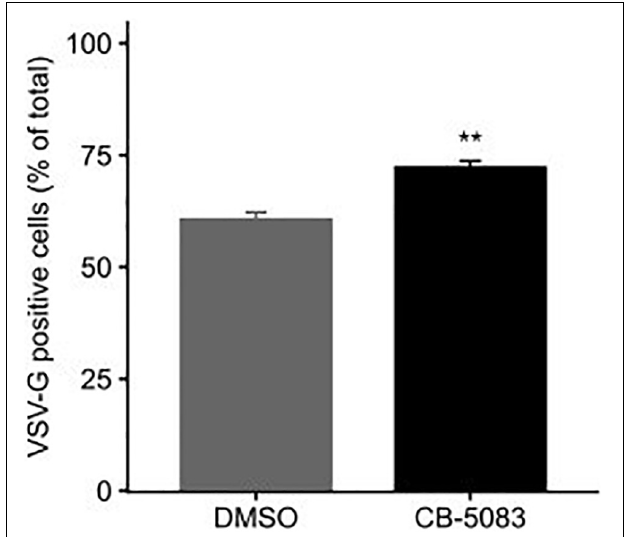
FIGURE 5 | VCP/p97 treatment does not block the trafficking of viral glycoproteins to the surface. Cells were transfected with a plasmid encoding the VSV glycoprotein (VSV-G). Following 24 h, cells were either treated or mock-treated with the VCP/p97 inhibitor CB-5083. Following an additional 24 h, VSV-G expression was assessed by flow cytometry. Data represent the mean and SEM of three replicates. ** p < 0.01 by t